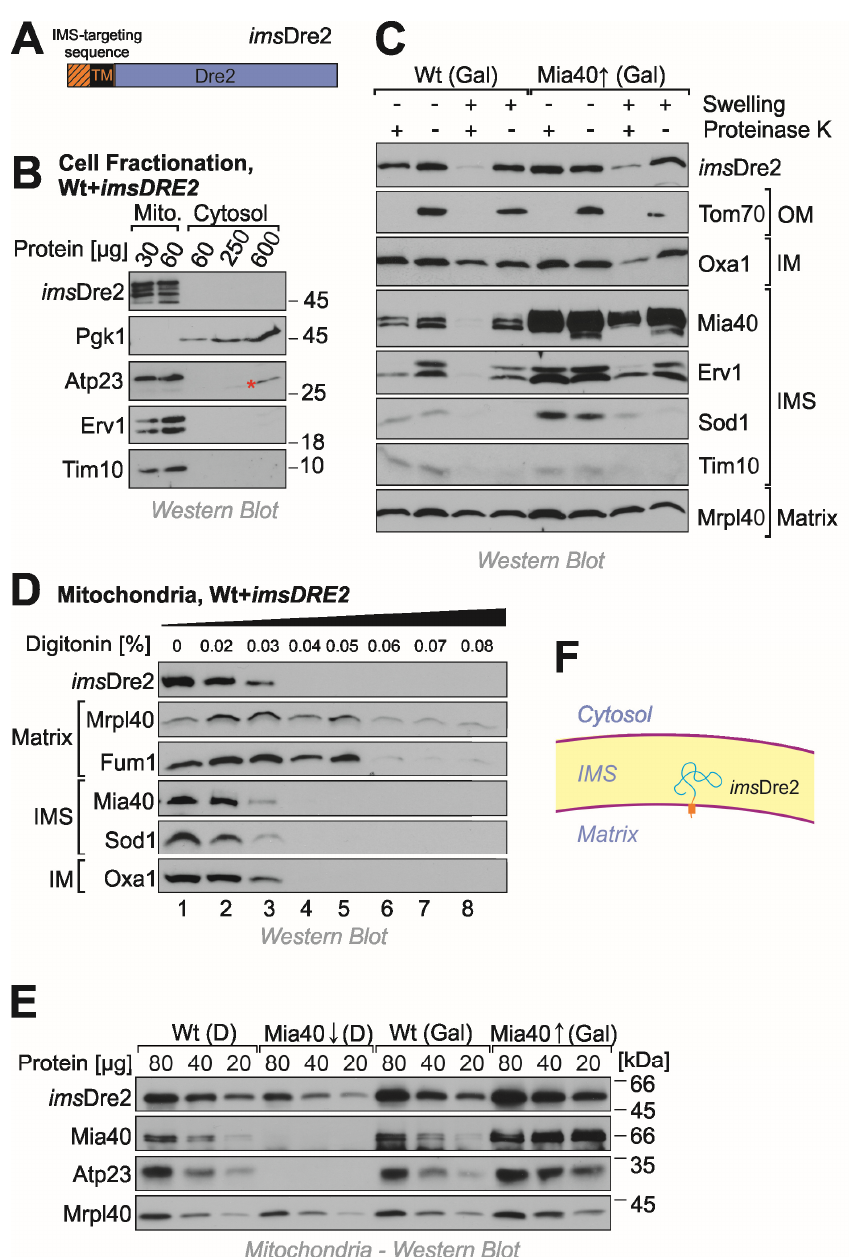
FIGURE 4: Dre2 can be directed in- to the IMS when fused to an IMS- targeting presequence. (A) Sche- matic structure of the ims Dre2 fu- sion protein. TM, transmembrane domain. (B) Cellular fractionation of ims Dre2-overexpressing wild type cells. Some degradation of ims Dre2 is visible due to the long exposure time used for this Western blot ex- periment. The asterisk indicates a crossreaction of the Atp23 anti- body. (C) ims Dre2 was expressed in wild type or Mia40-upregulated cells. Mitochondria were isolated and fractionated by hypotonic swelling as described in Fig. 1E. (D) Digitonin treatment of isolated mi- tochondria as described in Fig. 1F showing that ims Dre2 behaves like an IMS protein. (E) Steady state lev- els of ims Dre2 and control proteins were analyzed by Western blotting of mitochondria isolated from the indicated strains. (F) Scheme of the topology of the ims Dre2 fusion pro- tein in